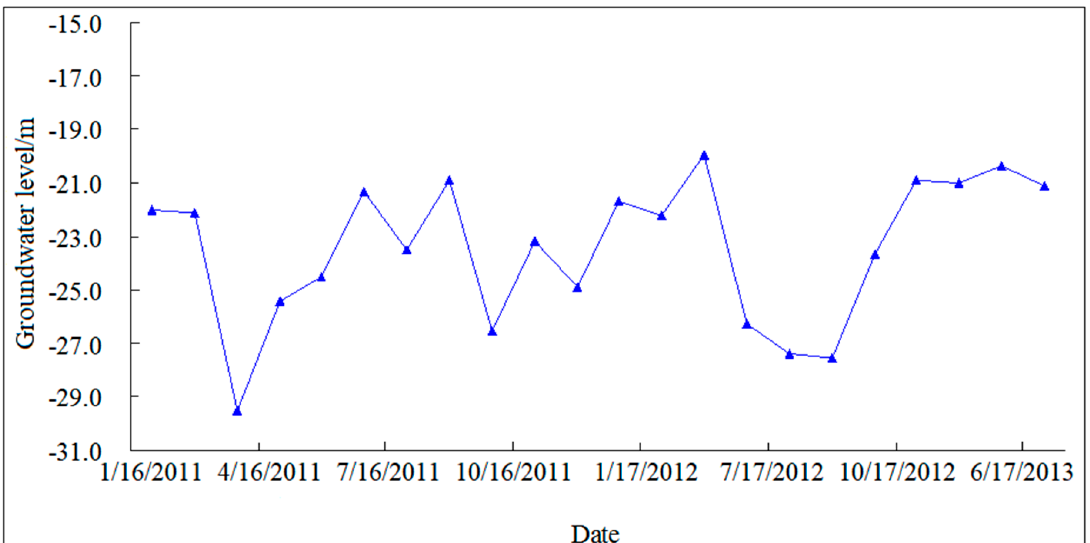
Figure 5. Dynamic variation of groundwater level in the second confined aquifer.